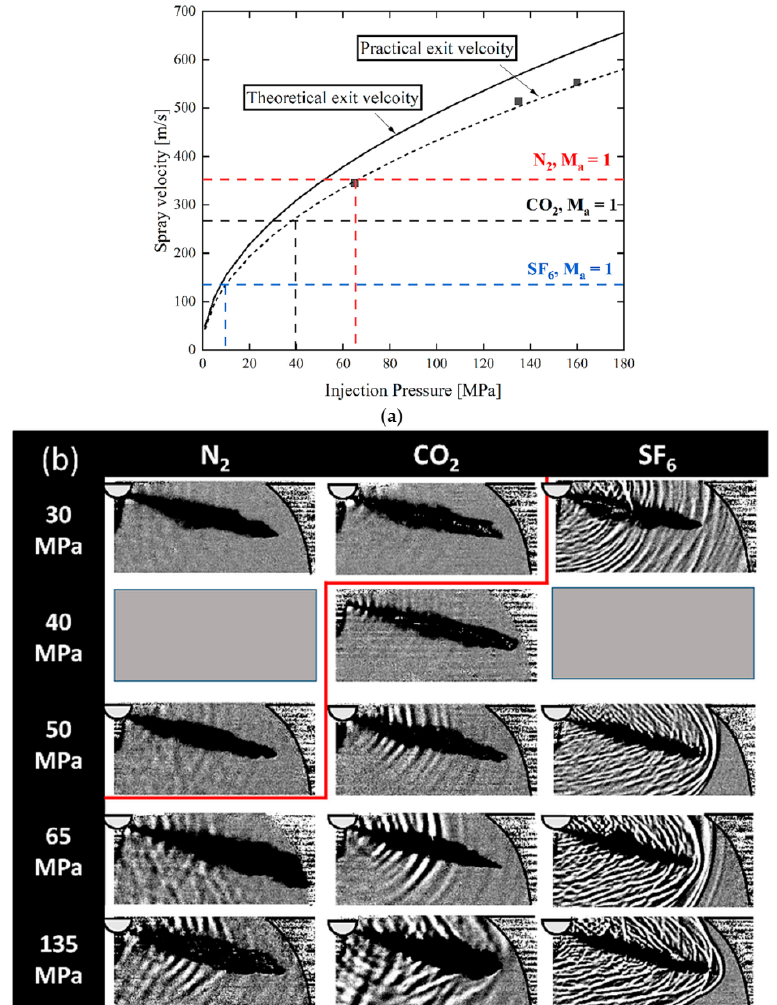
Figure 12. Spray velocity at the nozzle exit (predictions) and the maximum of spray tip velocity (experiments) in various injection pressures ( a ); shock-wave generation vs. injection pressure; ambient gas condition: 297 K and 9.0 kg / m 3 ( b